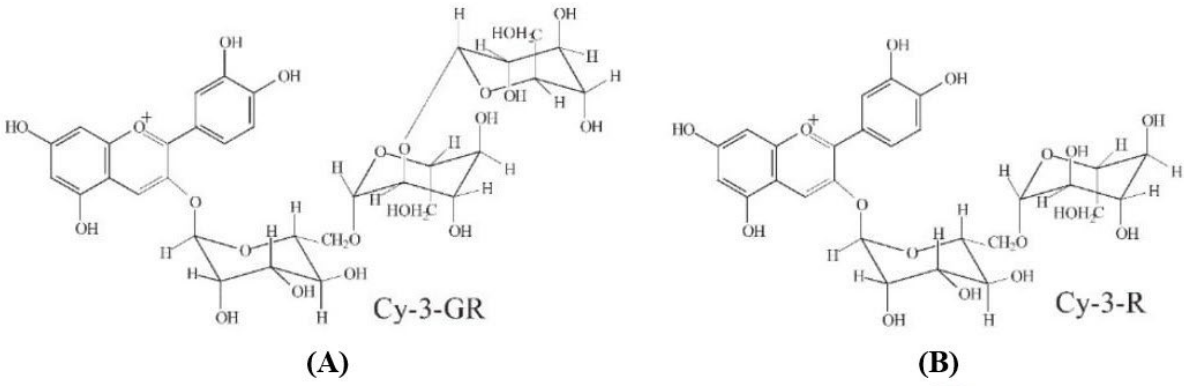
Figure 15. Structures of anthocyanins: ( A )—cyanidin-3-glucosylrutinsoid (Cy-3-GR) and ( B )—cya- nidin-3-rutinoside (Cy-3-R), characteristic of cherry fruits.